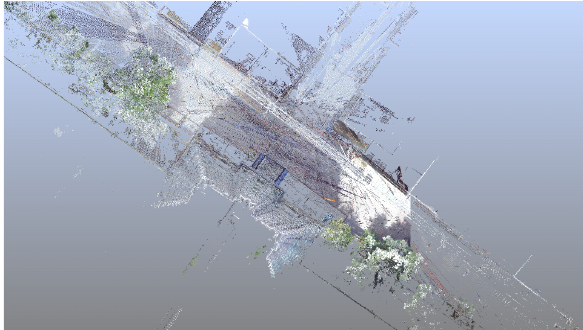
Figure 7. Plan view of TLS of Western gate of Minakshi